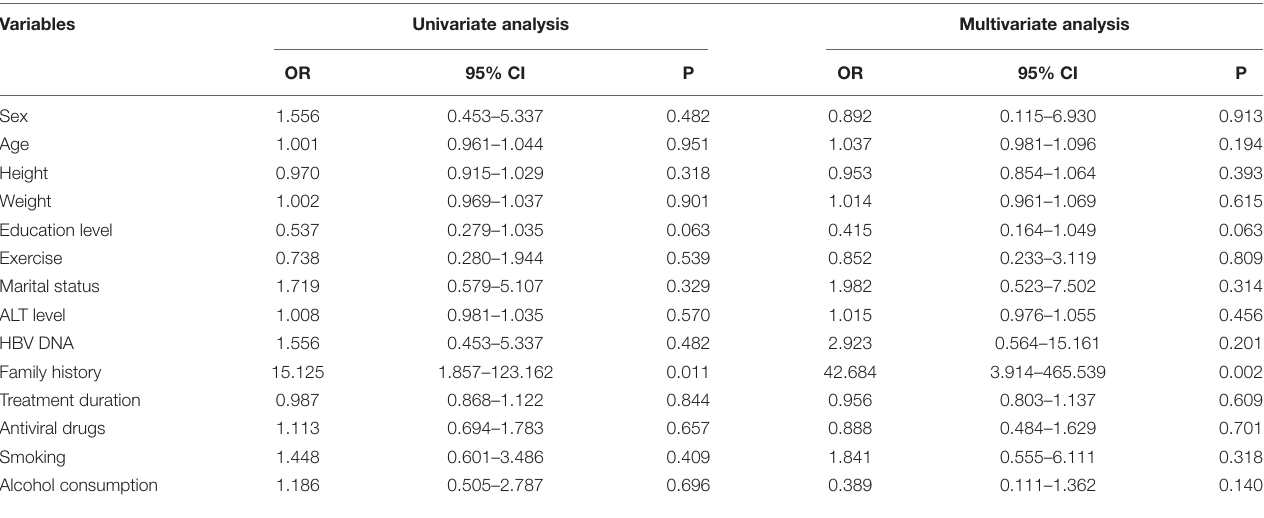
TABLE 4 | Multivariable analysis for psychological quality of